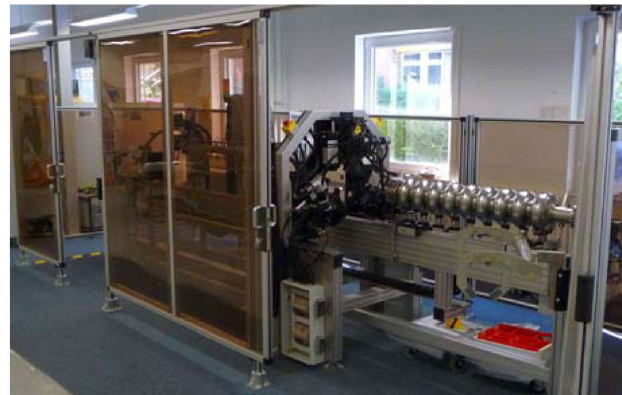
FIG. 17. (Color) The picture shows the tuning frame with the baseplate and the three vise units. On the cable channel the emergency switch is